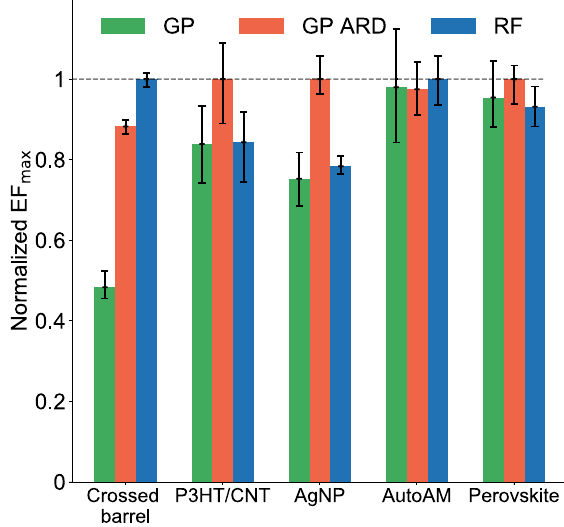
Fig. 4 Normalized EF max demonstrated by BO algorithms having GP without ARD, GP with ARD, and RF as surrogate models and all as acquisition function. In each dataset, the BO using LCB 2 algorithm with the largest EF max had its EF scaled to 1, and the other two BO algorithms showing lower EF max were correspondingly scaled, resulting in fi ve sets of column plots. For each algorithm applied across datasets, the median of EF max is shown by the barplots, and its 5 th and 95 th percentile are shown by respective fl oating